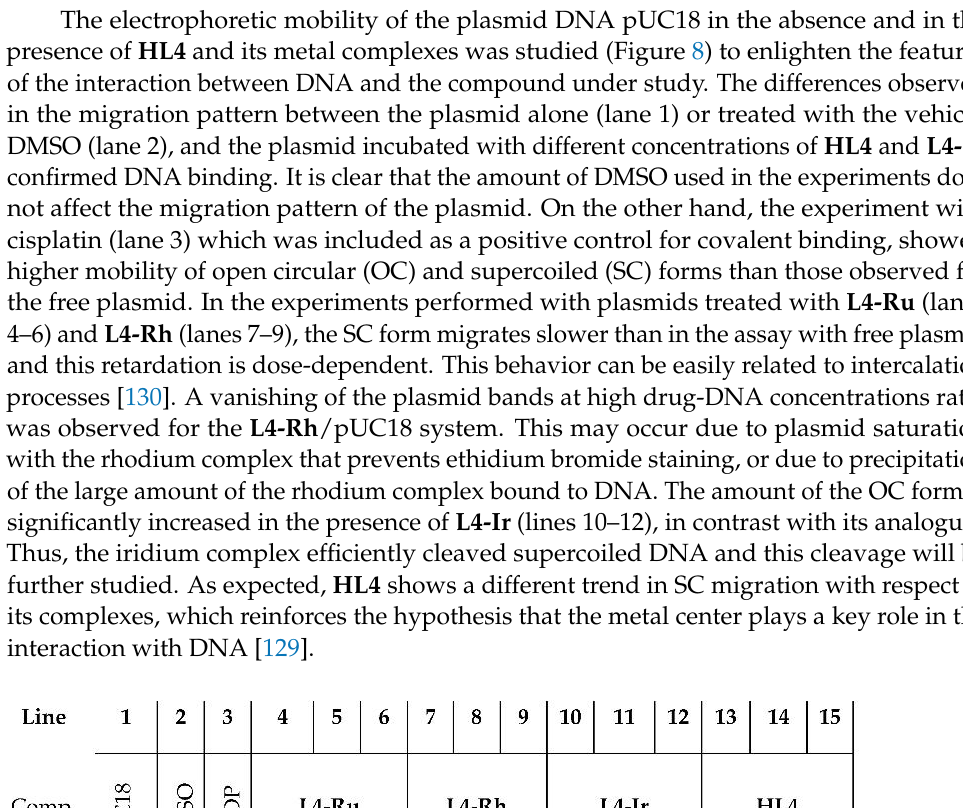
Lane 1 Figure 9. Cleavage electrophoresis of pUC18 (20 µM) incubated with L4-Ir or/and with DMSO (0.4 M and 2 M), L- histidine (1.2 mM and 12 mM), sodium pyruvate (2. 5 mM and 10 mM) or SOD (15 U and 120 U). Lane 13 is the control for pUC18 alone, and lane 14 is pUC18 with L4-Ir . 3.7. Intracellular ROS Generation